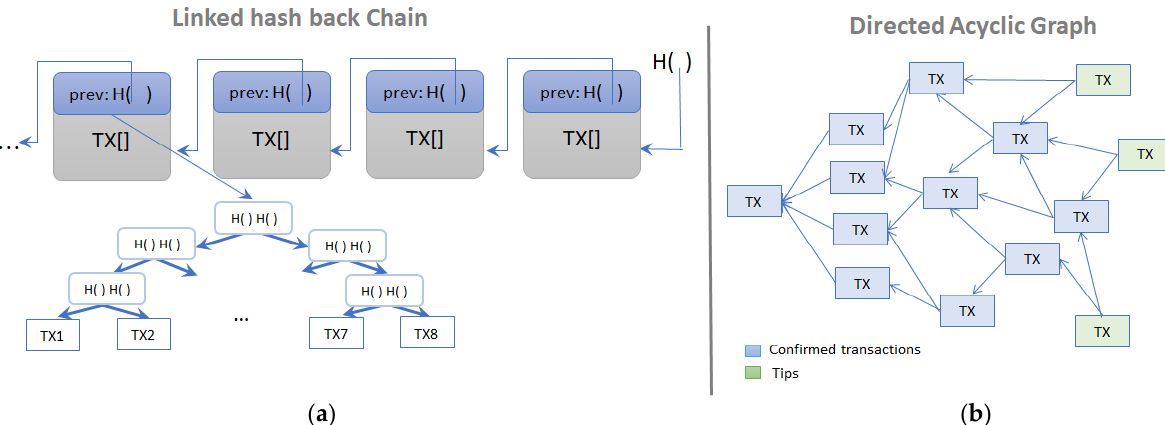
Figure 2. Data for representing peers’ transactions structures: ( a ) blockchain using linked lists and ( b ) Directed Acyclic Graphs (DAG).